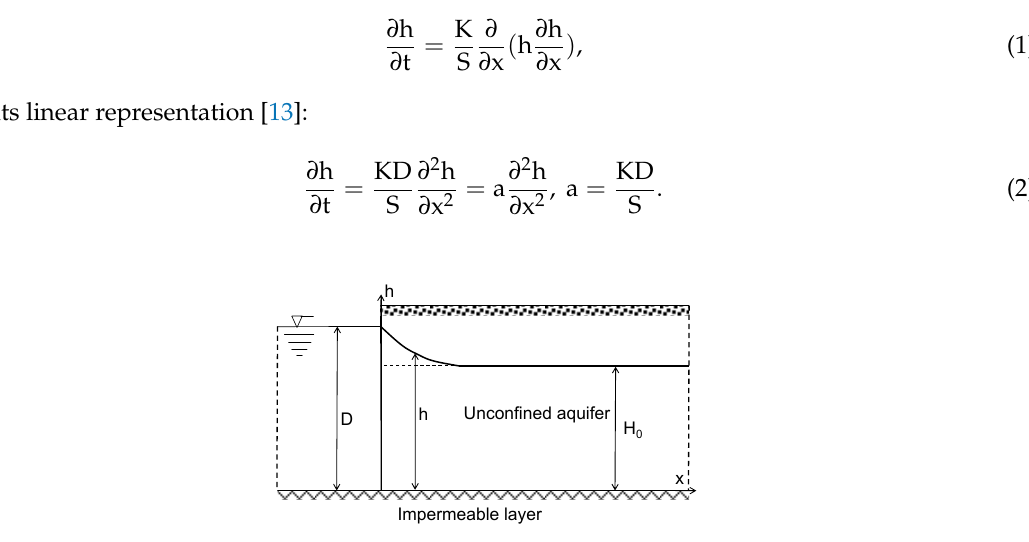
Figure 1. Aquifer recharging from the lake.